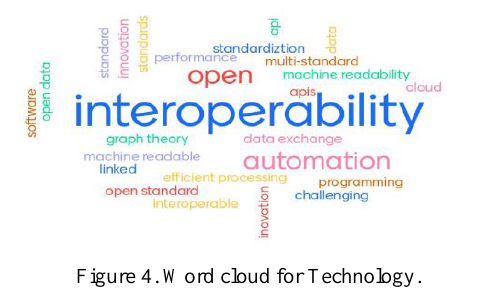
Figure 4. Word cloud for Technology.